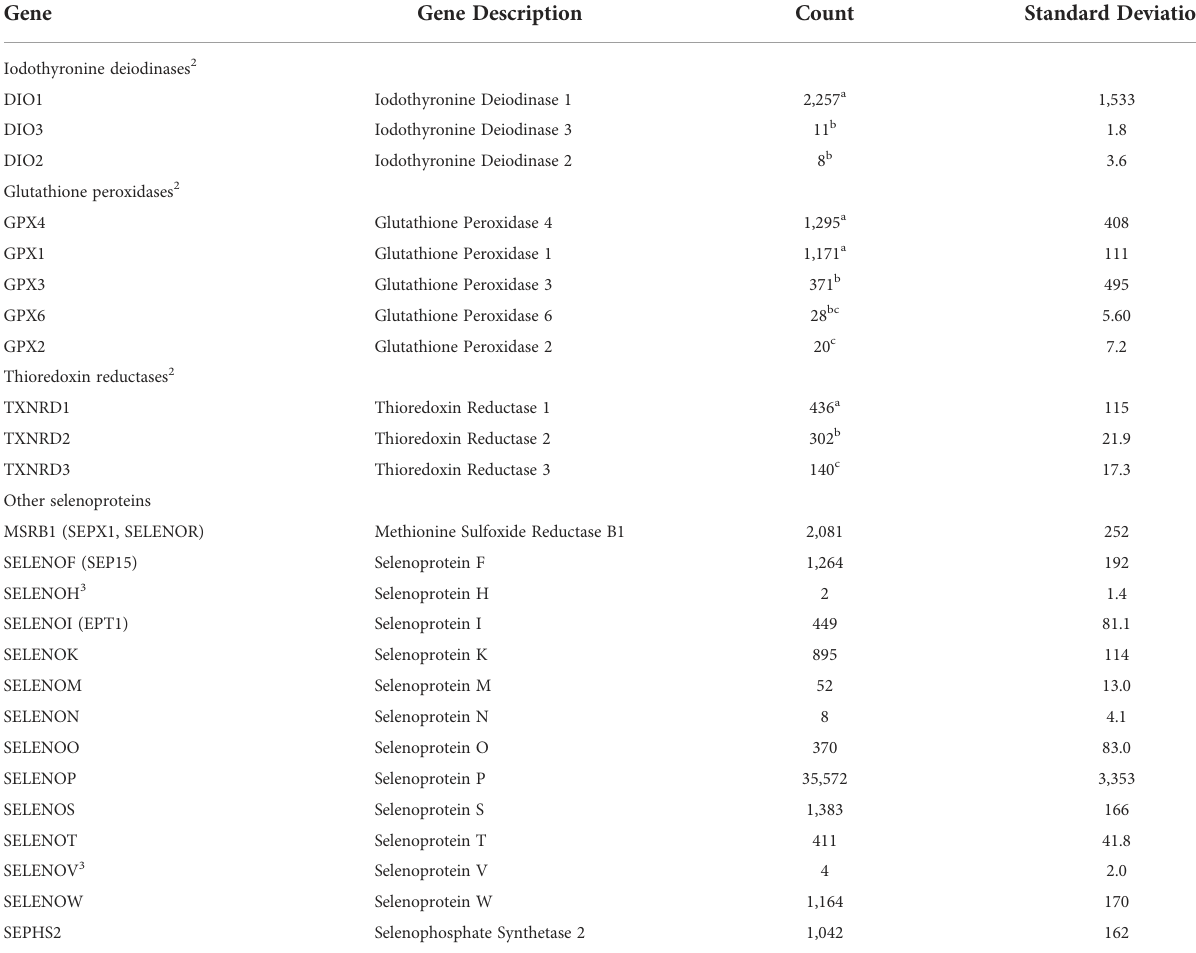
TABLE 3 NanoString analysis of bovine selenoprotein mRNA abundance (counts) in liver tissue of steers grazing high endophyte-infected forages and receiving inorganic supplemental selenium 1 . Gene Gene Description